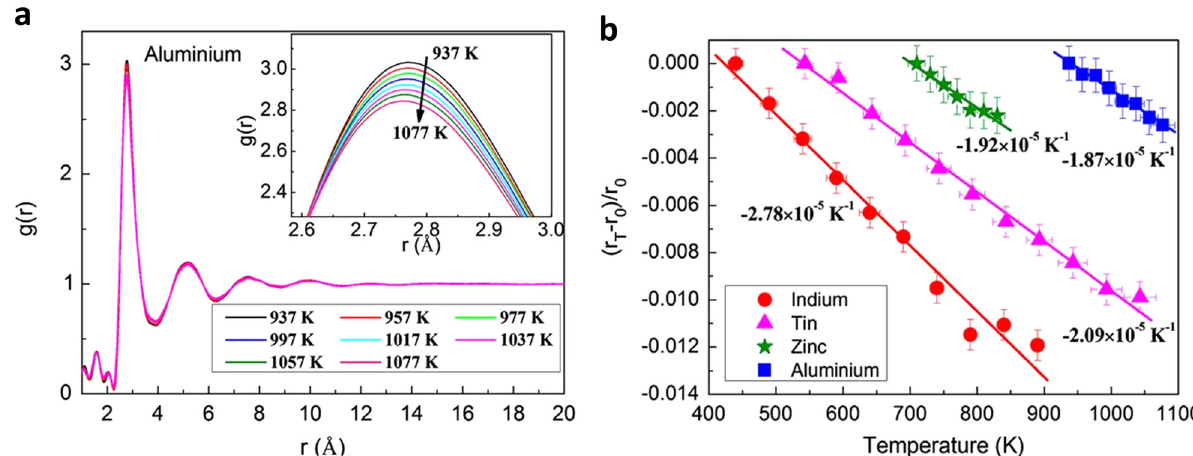
Fig. 4 Temperature - dependent fi rst peak position in g ( r ). a g ( r ) for Al liquids in the temperature range of 937 to 1077 K. The inset magni fi es the top part for the fi rst peak in g( r ), where the peak intensity decreases and the position corresponding to the maximum intensity shifts to low r upon heating. b The same was found for the fi rst peak position in g ( r ) for other metallic melts in addition to Al. The lines are the linear fi t of the peak position. Adapted from ref.